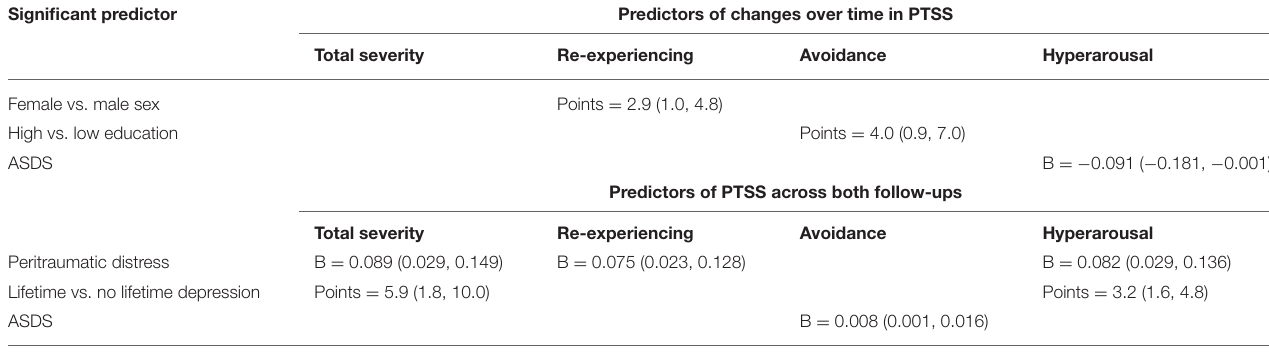
TABLE 3 | Predictors of post-traumatic stress